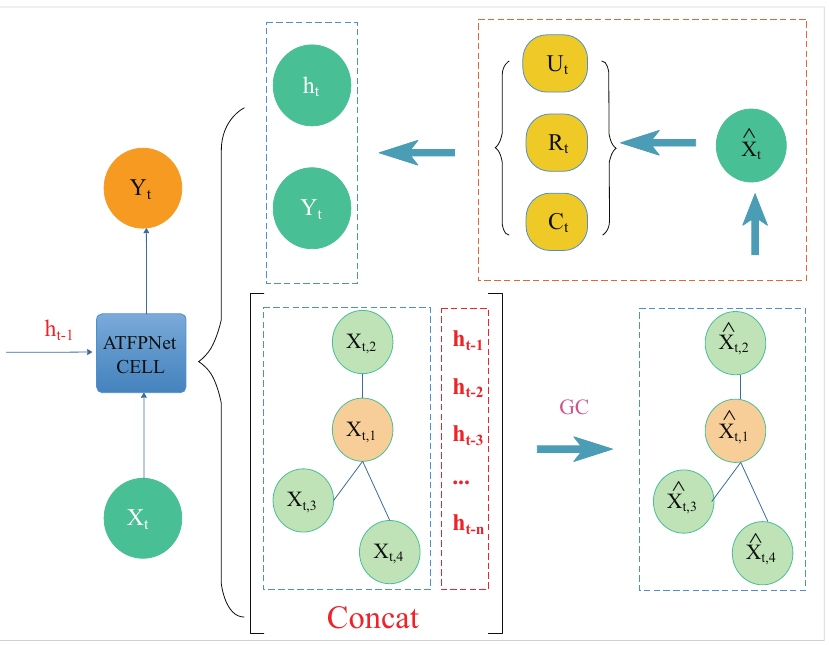
Figure 2. The architecture of an ATFPNet